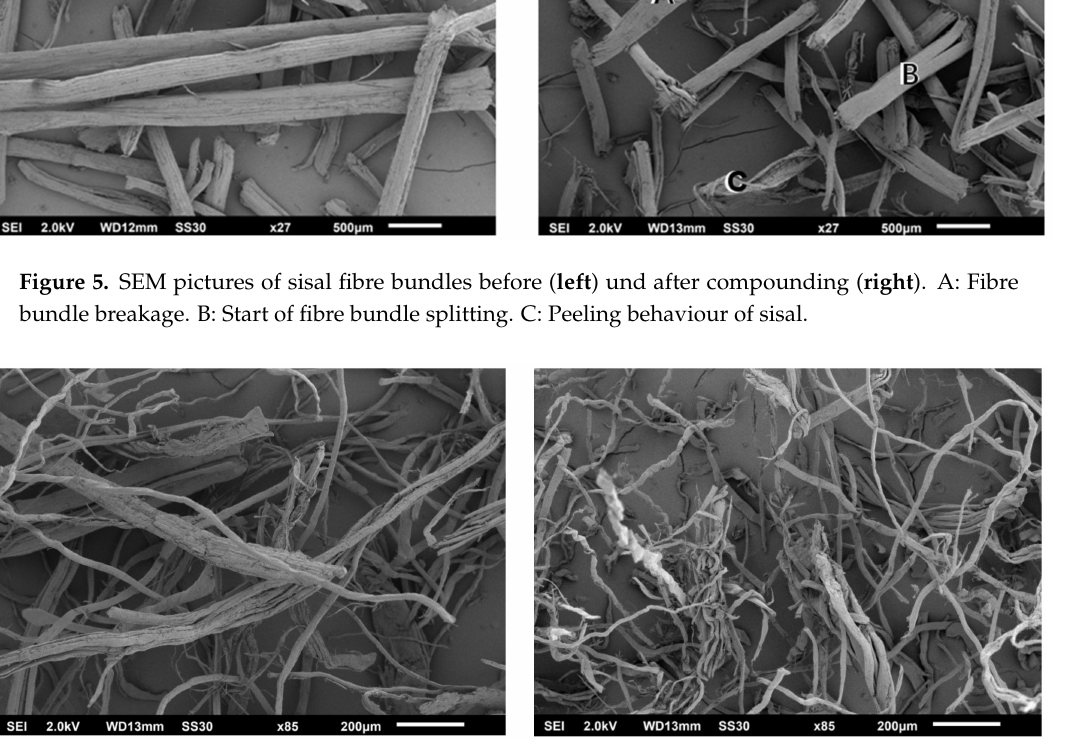
Figure 6. SEM pictures of flax fibre bundles before ( left ) und after compounding ( right